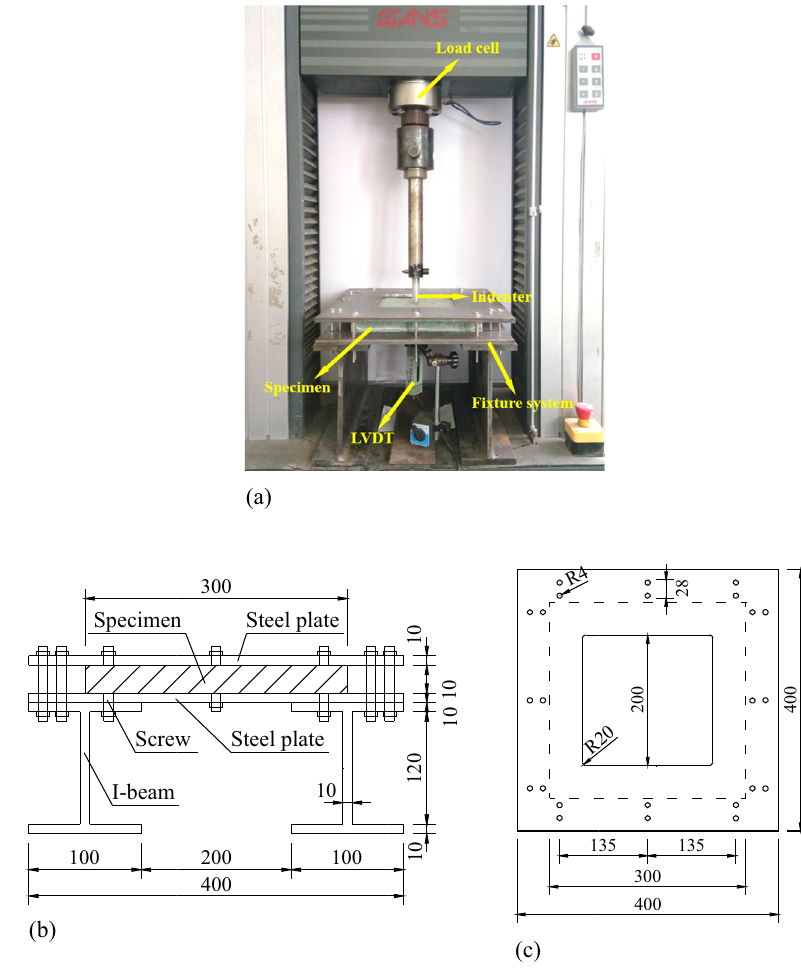
Figure 2: Test setup and fixture system ( unit: mm ) . ( a ) Test setup. ( b ) Side view of fixture system. ( c ) Vertical view of fixture